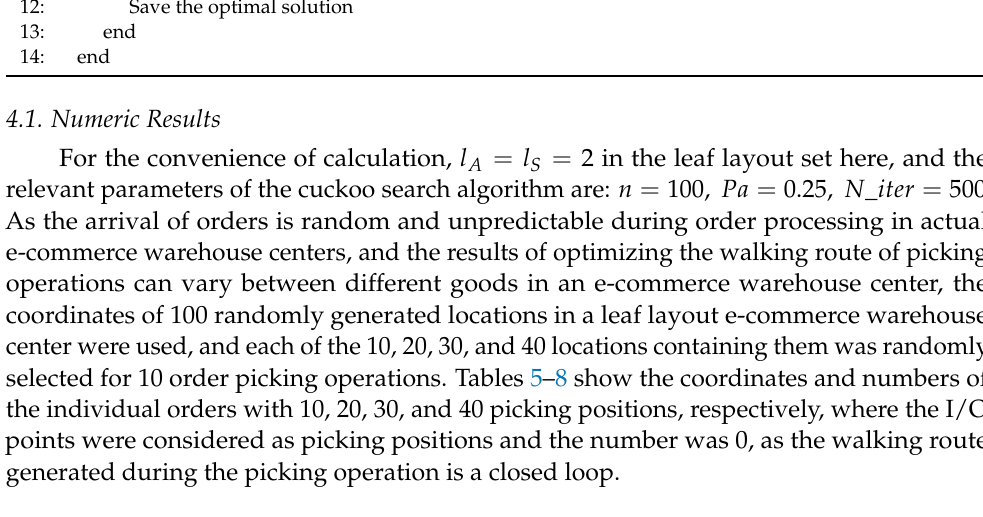
Table 5. Coordinates and number when the number of locations to be visited is